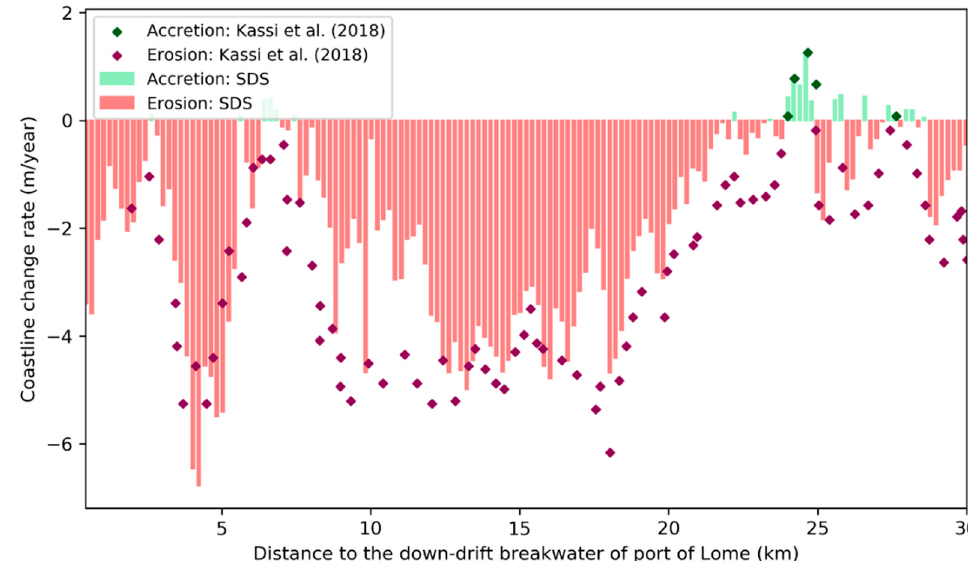
Figure 15. Spatial accretion (in green) and erosion (in red) patterns expressed in coastline change rates (m/year) for shore-normal transects down-drift of Lomé between 1986 and 2017. The results of Kassi et al. [21] are represented by dots and our results by bars.